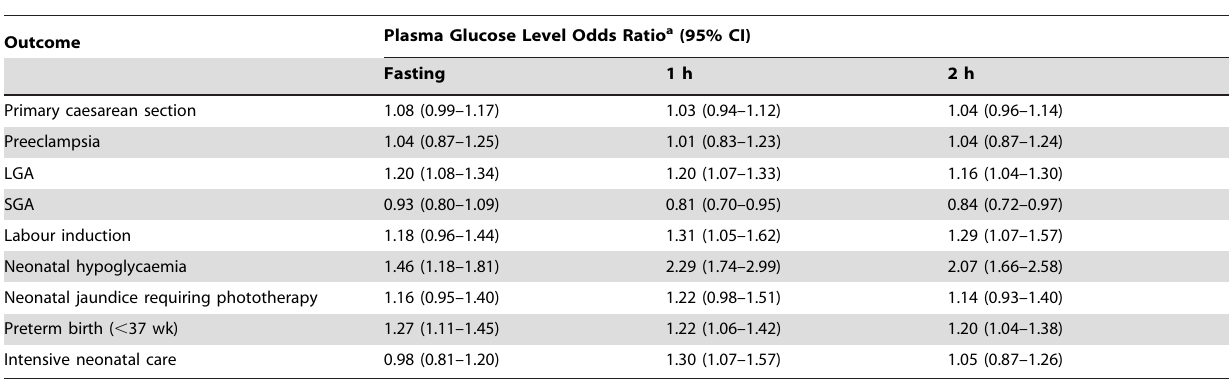
Table 5. Outcomes related to the 75-g oral glucose tolerance test results analysed as continuous